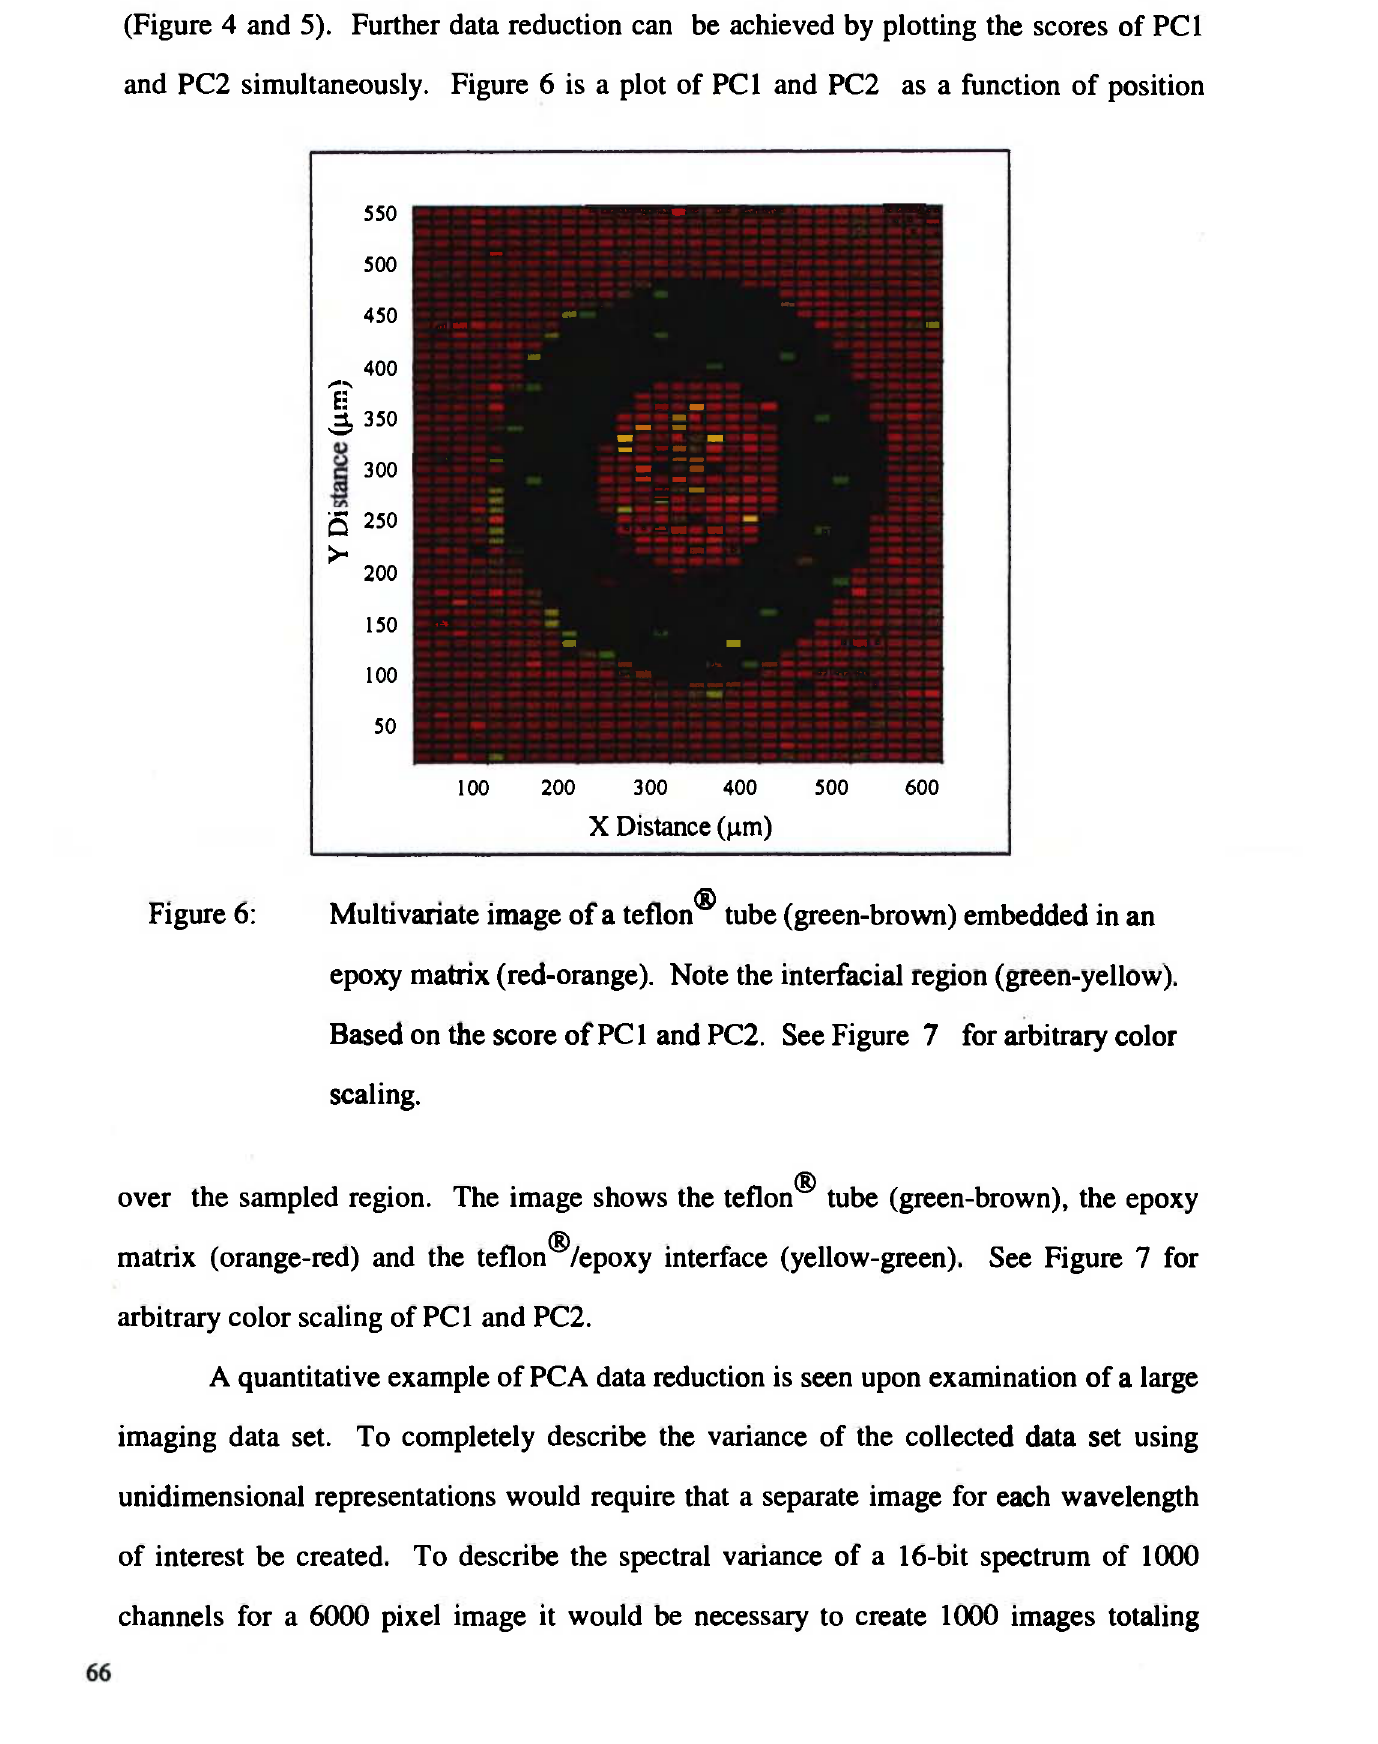
Figure 6: Multivariate image of a teflon tube (green-brown) embedded in an epoxy matrix (red-orange). Note the interfacial region (green-yellow). Based on the score of PCI and PC2. See Figure 7 for arbitrary color scaling. ® over the sampled region. The image shows the teflon tube (green-brown), the epoxy ® matrix (orange-red) and the teflon /epoxy interface (yellow-green). See Figure 7 for arbitrary color scaling of PCI and